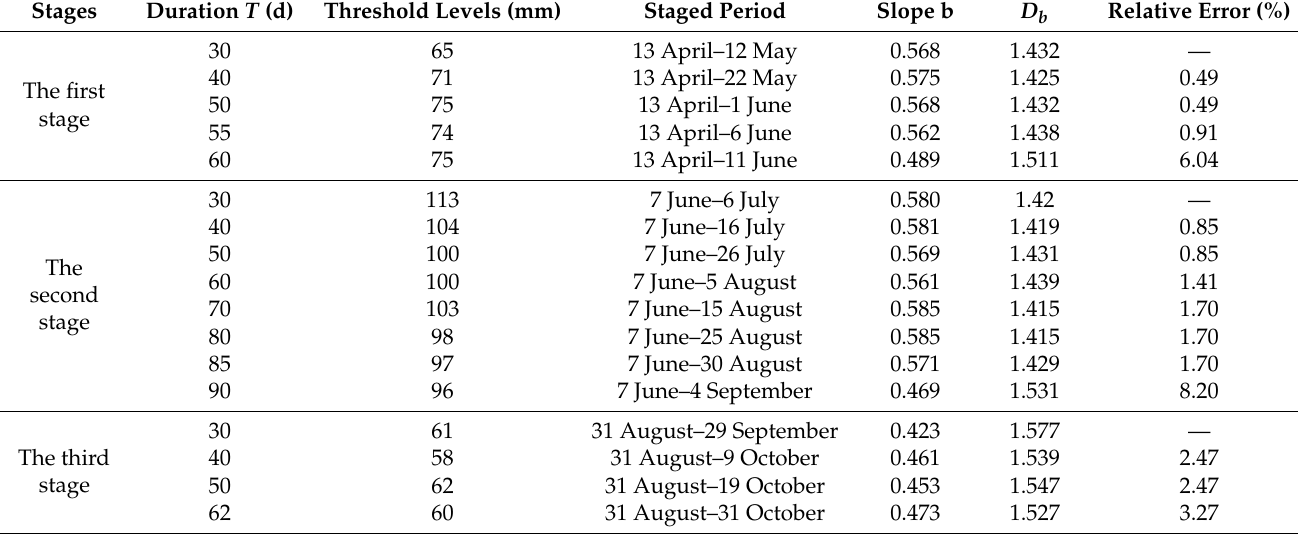
Table 3. Staging results of multi-year maximum daily